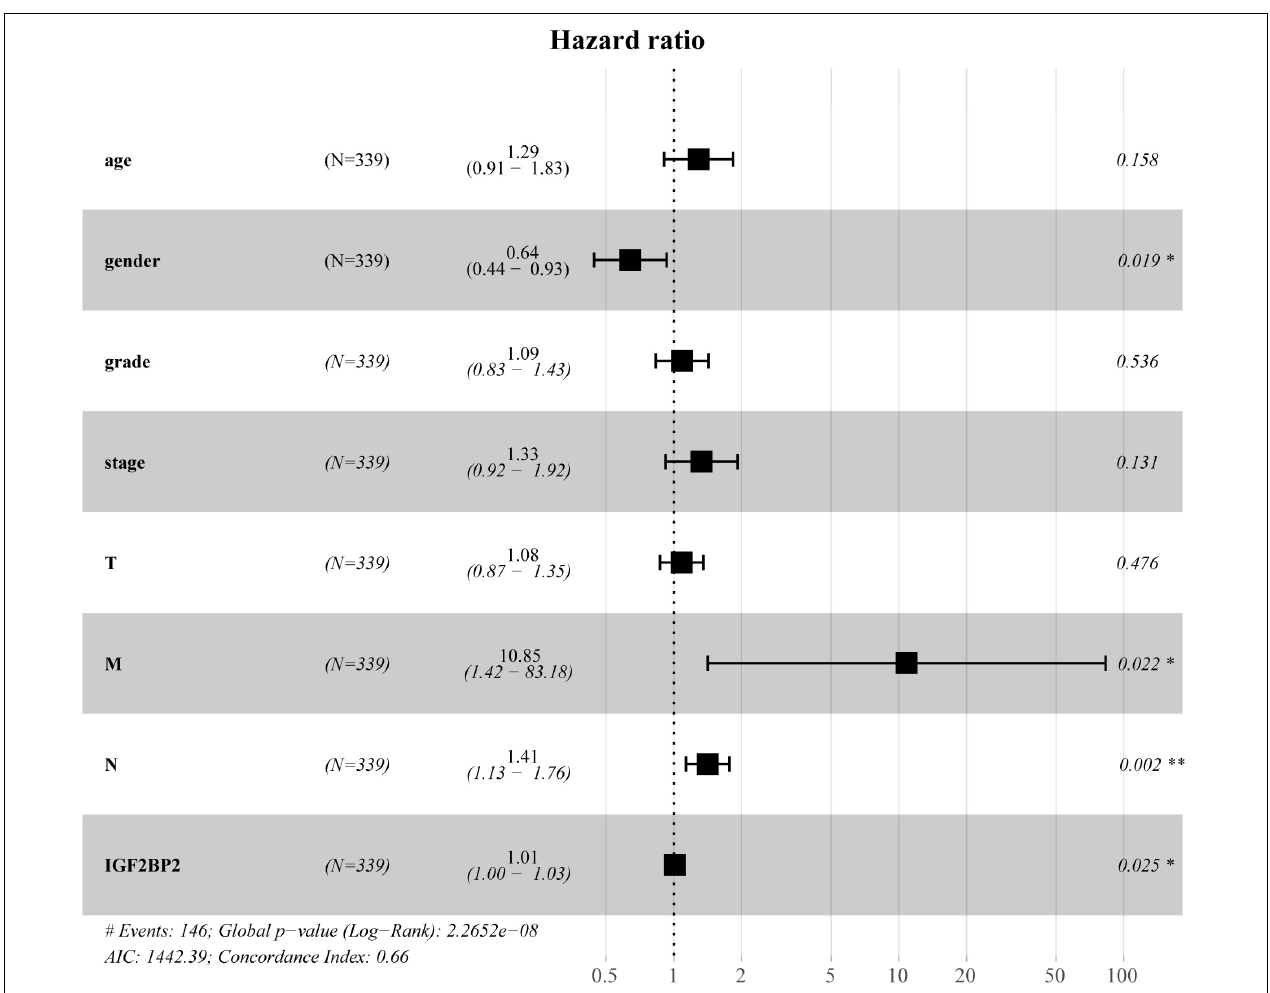
FIGURE 5 | Forest Map Analysis of Expression and clinicopathologic